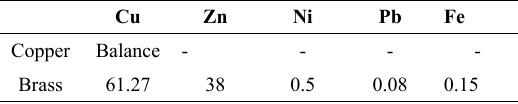
Table 1. The chemical composition of base metals was used in this paper (Wt.